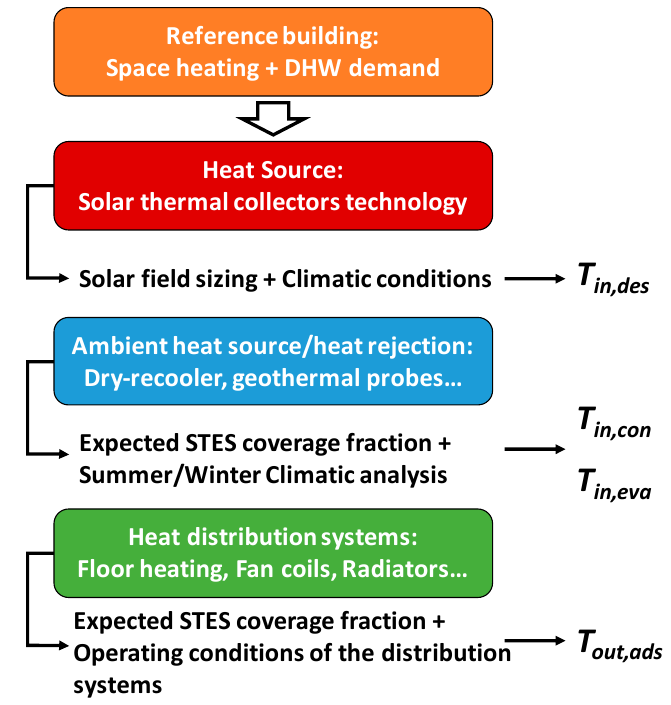
Figure 2. Steps to identify the main operating temperatures of the sorption STES.